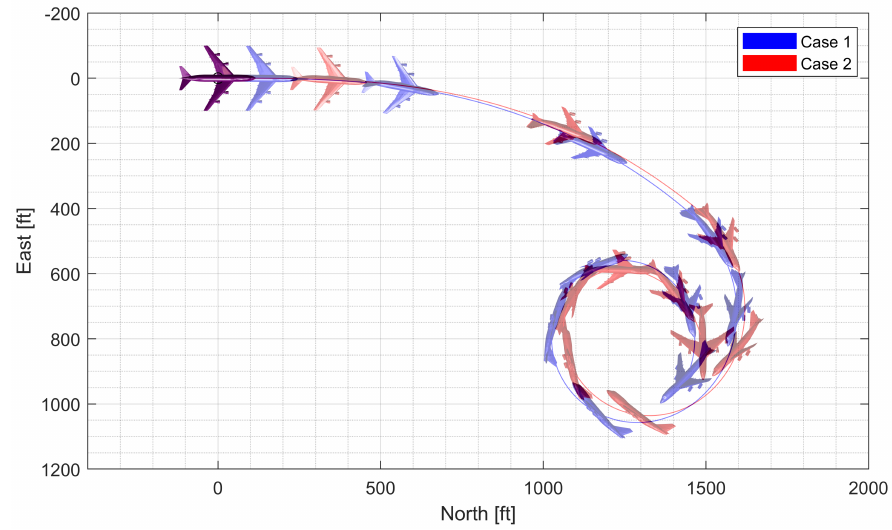
Figure 14. Flight trajectory of the high-g turn (LPV).